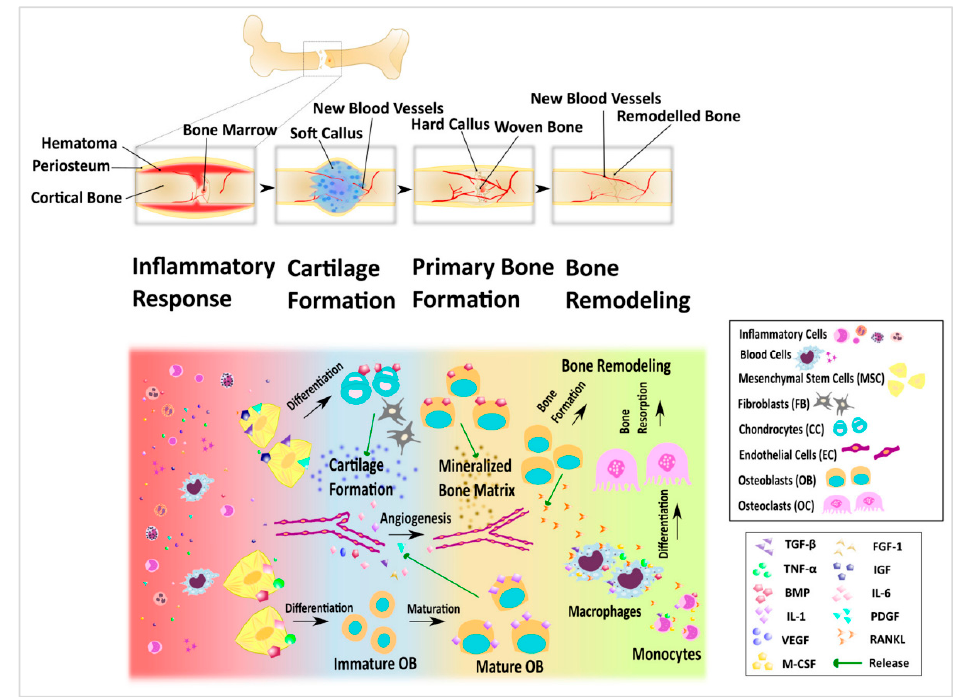
Figure 7. Phases for of bone breakage healing